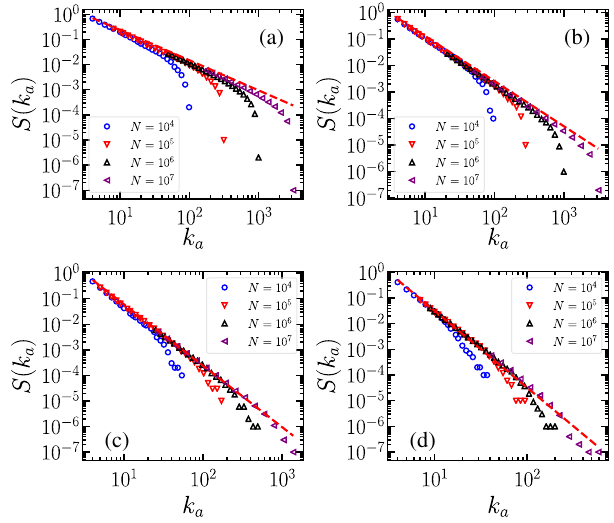
FIG. 5. Fraction S of nodes in the largest CMP component as a function of k for various γ values: γ ¼ 2 . 2 (a), γ ¼ 2 . 7 (b), γ ¼ a 3 . 2 (c), and γ ¼ 3 . 5 (d). In all cases, k 3 . Symbols represent min ¼ numerical results for various network sizes. Dashed lines are theoretical predictions from Eqs. (8) [(a),(b)] and (17)